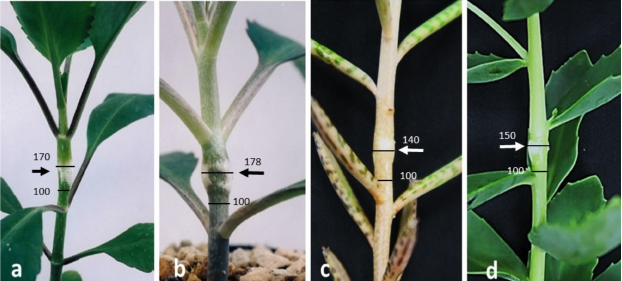
Figure 1. Conspicuous local stem swelling in succulent plants induced by NPA (0.4%, w/w in lanolin) after 8 days of treatment. ( a ) Bryophyllum calycinum, ( b ) B. daigremontianum , ( c ) Kalanchoe tubiflora , and ( d ) Sedum spectabile. Arrows indicate the site of NPA application as a 2-mm-wide ring of lanolin paste around the stem in the intensively growing internode. Values with lines in the photographs indicate relative stem diameter (%) to the non-treated area (100%) based on the photographs.